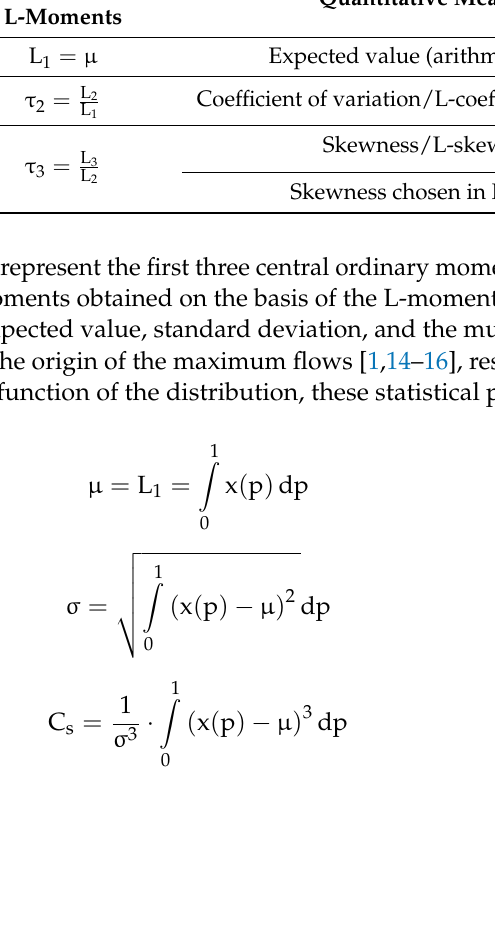
Table 2. Statistical parameters. Statistical